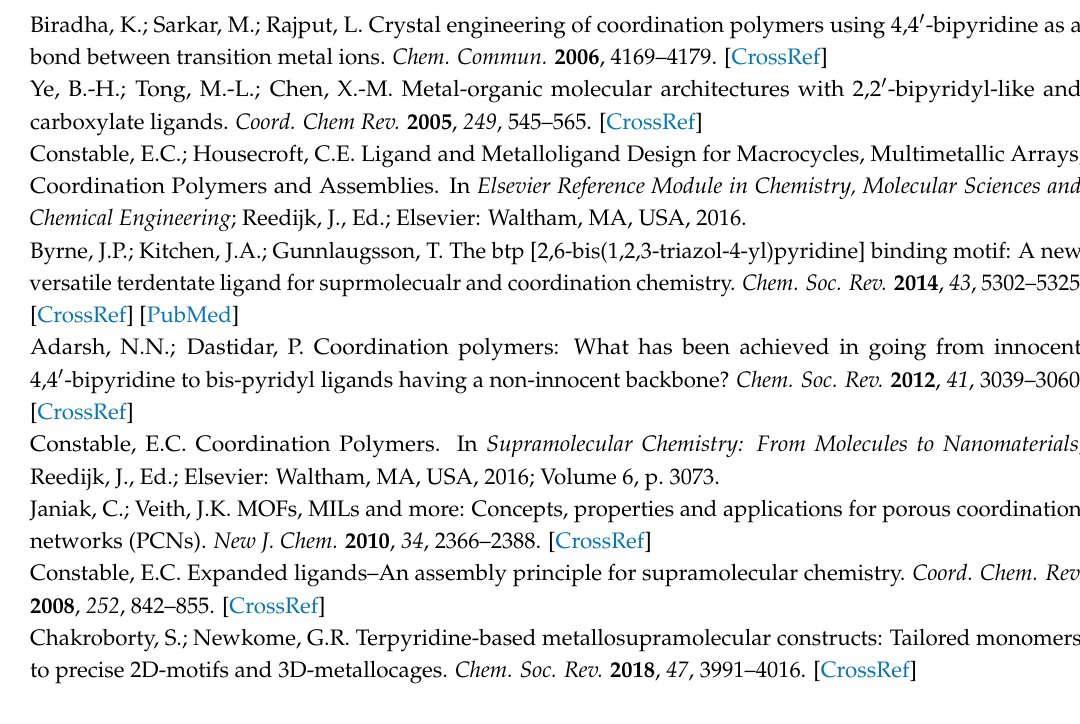
Supplementary Materials: The following are available online at http://www.mdpi.com/2073-4360/10/12/ 1369/s1, Figure S1: Powder diffraction data for the bulk sample of {[Co(NCS) 2 ( 4 )] · 1.6H 2 O · 1.2C 6 H 4 Cl 2 } n . Figures S2–S4: High resolution electrospray (HR-ESI) mass spectra of 3 , 4 and 5 . Figures S5–S10: 1 H and 13 C NMR spectra of 3 , 4 and 5 . Figure S11: Overlay of {Co 4 ( 3 )} and {Co 4 ( 1d )} units in {[Co(NCS) 2 ( 3 )] · 0.8C 6 H 4 Cl 2 } n and